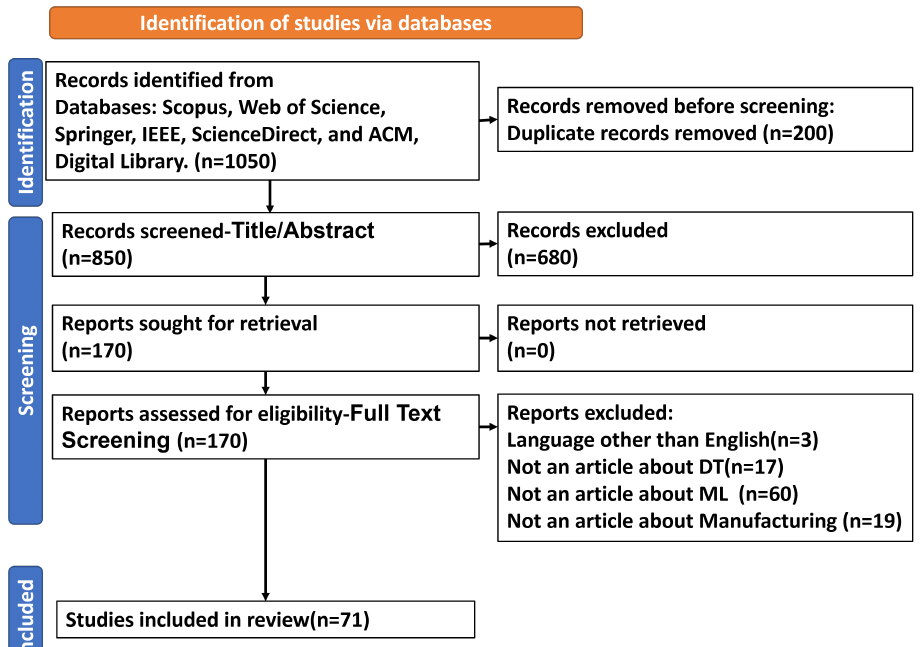
Figure 3. The process to identify the primary studies. Screening method shown with help of numbers, icons and connecting